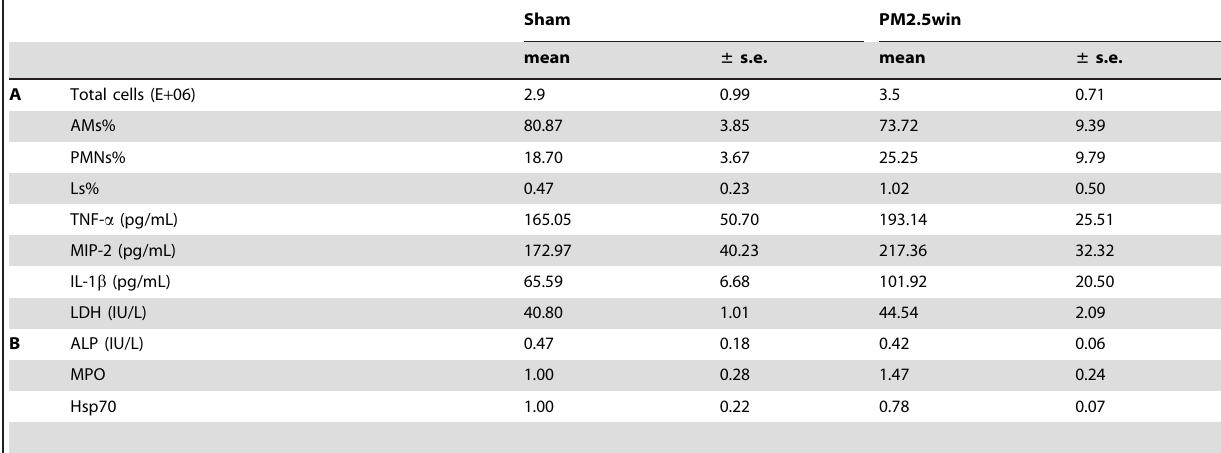
(A): table summarizing results of cell counts and biochemical analyses in BALf from sham and PM2.5win-treated mice, 24 h after the third intratracheal instillation. Statistical differences were tested accordingly by non-parametric U Mann-Whitney test. All the examined markers resulted unchanged comparing to sham. (B): immunoblotting results in BALf from sham and PM2.5win -treated mice, 24 h after the third intratracheal instillation; each protein in PM2.5win-treated group has been normalized onto respective sham group. Statistical differences were tested accordingly by non-parametric U Mann-Whitney test. All the examined